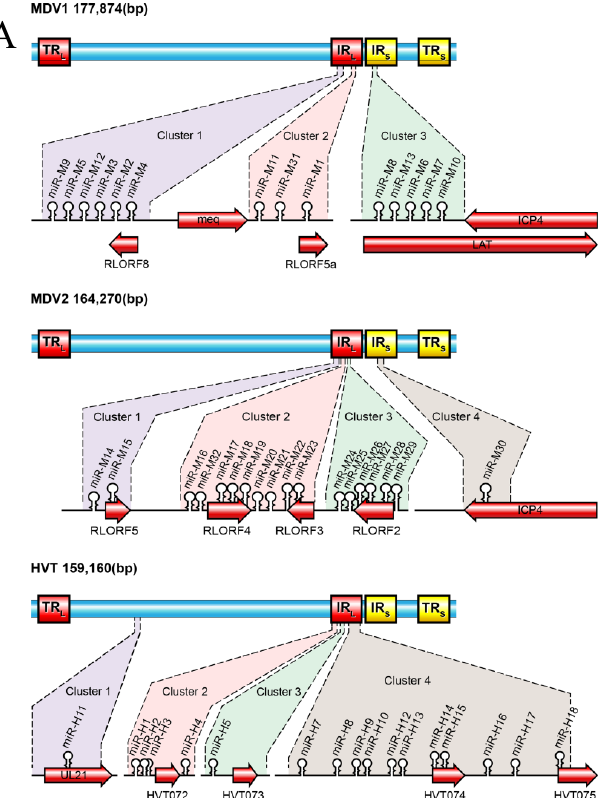
Figure 1. Diagrammatic representation of the viral genomes showing the positions of miRNAs of Marek’s disease virus-1 (MDV1), Marek’s disease virus-2 (MDV2), herpesvirus of turkey (HVT) ( A ) and infectious laryngotracheitis virus (ILTV), duck enteritis virus (DEV) and avian leukosis virus subgroup J (ALV-J) ( B ). Position and orientation of selected transcripts are shown. The genome size (base pairs) of viruses is shown on the top-left